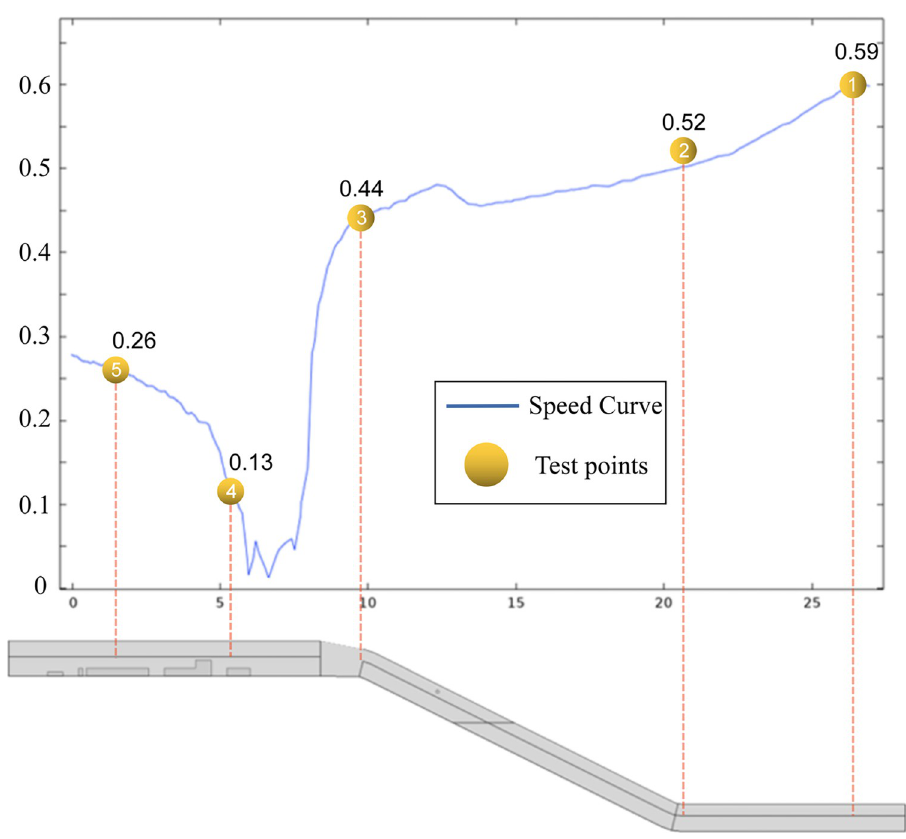
Fig 6. Data comparison